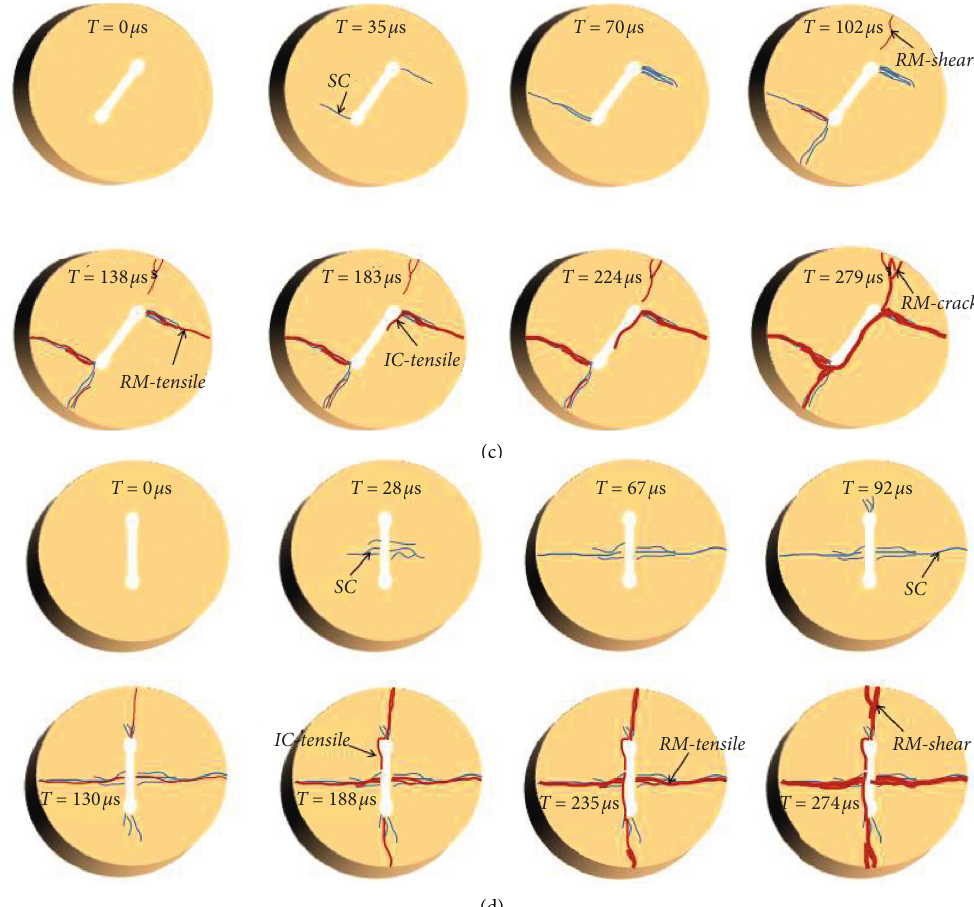
Figure 7: Schematic diagram of crack propagation in the fractured sandstone. (Note: IC is interface crack; RM is rock matrix; SC is stress- concentration) (a) T �− 5 ° C, θ � 0 ° . (b) T �− 5 ° C, θ � 30 ° . (c) T � − 5 ° C, θ � 60 ° . (d) T � − 5 ° C, θ � 90 °